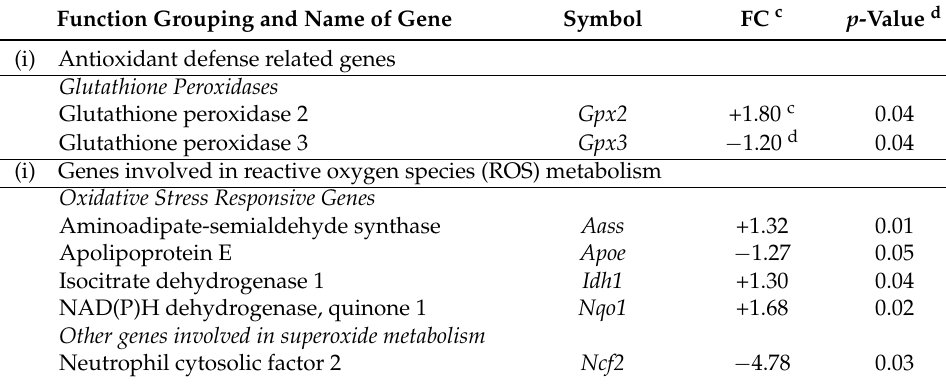
Table 5. Fold change a and p -values of the genes affected by dietary consumption of GRE b during the 28 study with male Fischer rats ( n = 3 per